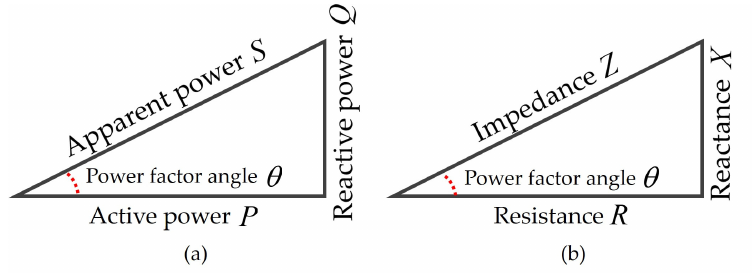
Figure 5. Figures for describing complex power: ( a ) power triangle and ( b ) impedance